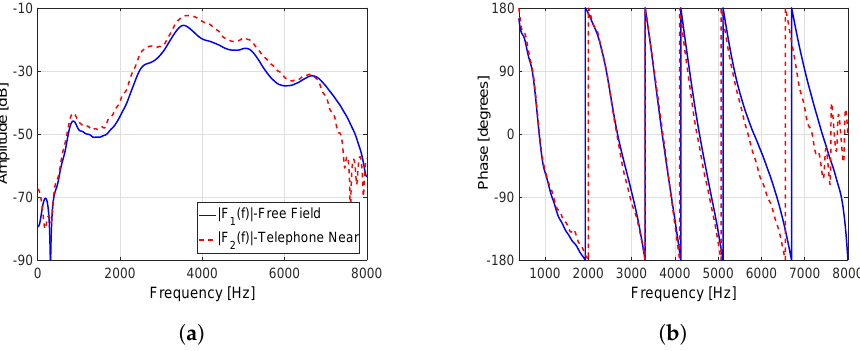
Figure 7. Measured feedback paths: ( a ) Amplitude responses and ( b )